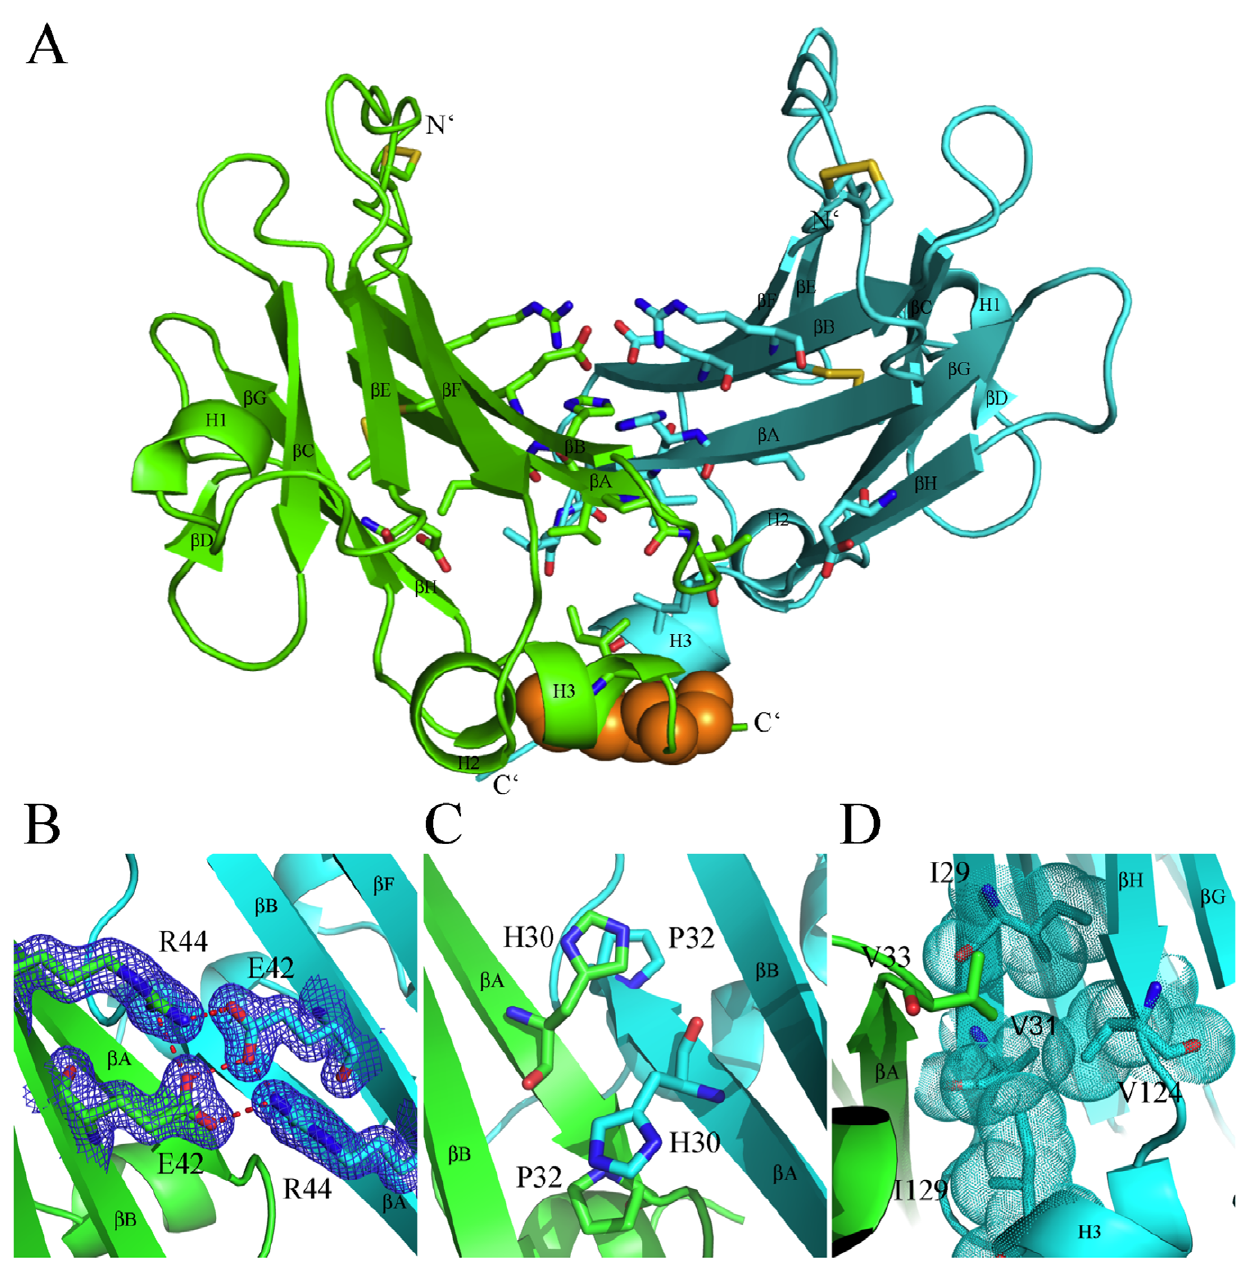
Figure 3. Key interactions of the YLDV-IL18BP homo-dimer. A). YLDV-IL18BP dimerizes back-to-back, abutting on one edge of the Ig-fold through extensive hydrophobic interactions. The secondary structures are labeled. The inter-chain C132-C132 SS bond is shown as orange spheres. B). The E42 from one protomer appears to be protonated, forming a hydrogen bond with E42 from the other protomer. E42 also forms both intra- chain and inter-chain hydrogen bonds with R44. E42 and R44 residues are shown as sticks. The 2mFo-DFc electron density map is shown in blue. C). Hydrophobic stacking of residues H30 and P32 of one YLDV-IL18BP protomer with their counterparts of the other protomer. D) Residue V33 of one protomer is inserted into the hydrophobic platform comprised of I29, V31, V124, and I129 of the second